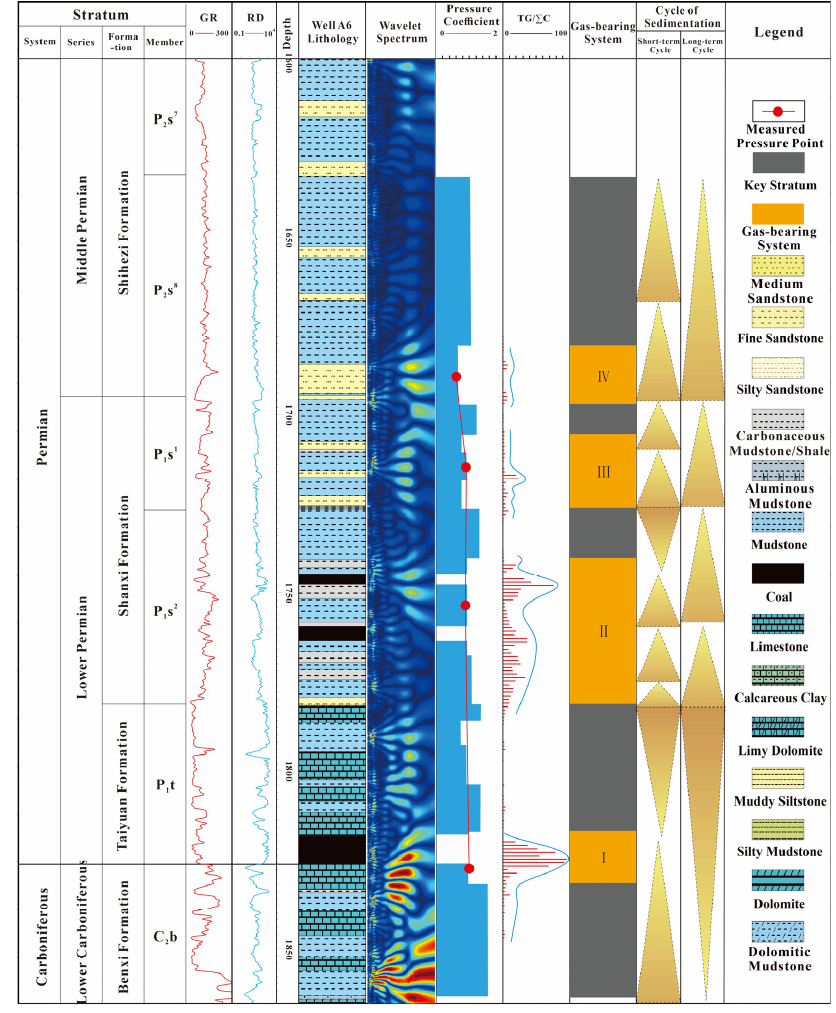
Figure 7. Identification and division of gas-bearing system in the study area. Energies 2023 , 16 , x FOR PEER REVIEW